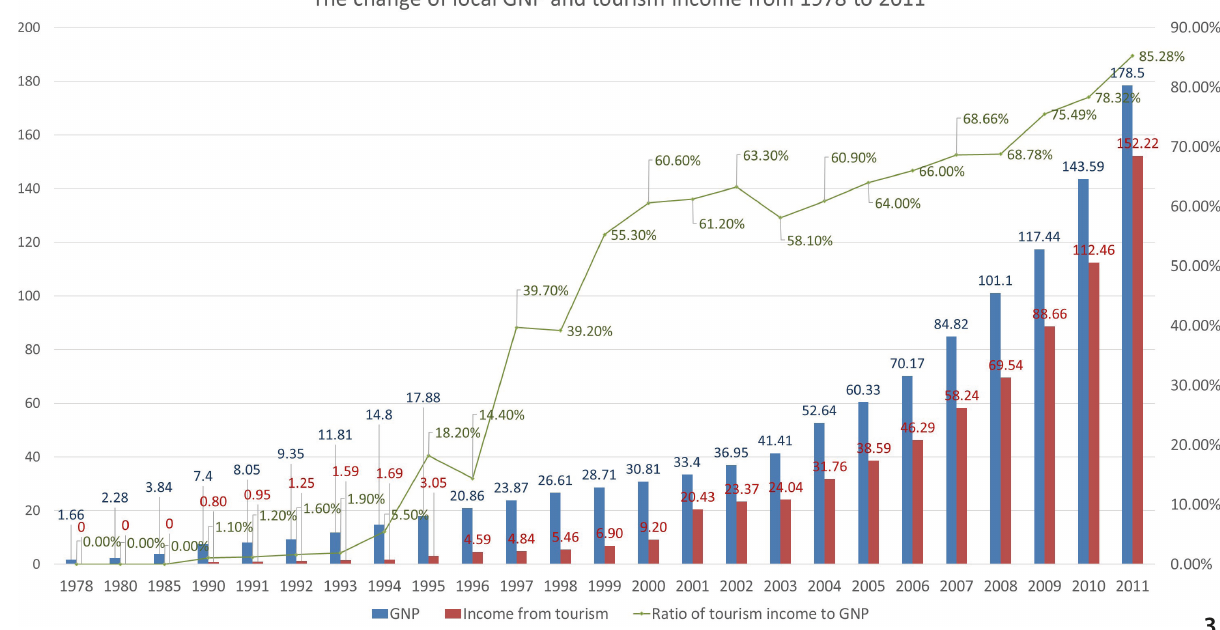
Figure 3 The change trend of GNP and tourism income of Lijiang Municipality between 1978–2011 (Units: Billion CNY) (Source: Drawn by the au- thor according to the Statistical Yearbooks and Statistical Bulletins of Lijiang Municipality and Gucheng